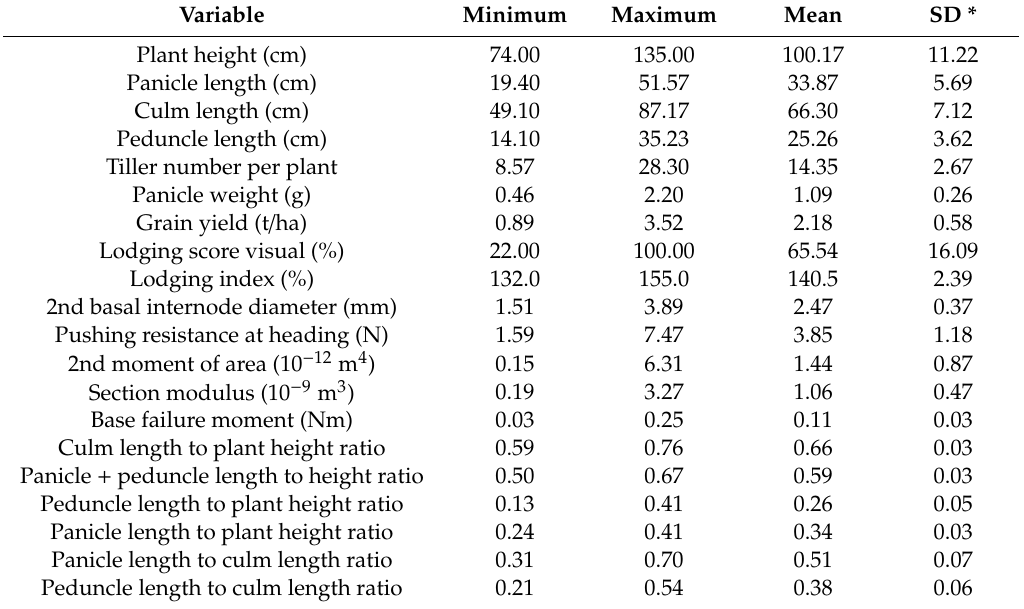
Figure 2. Internode and culm diameter trends across locations and years and along plants (internodes were counted from the ground upward). The same uppercase letters above bars indicates no significant differences ( p < 0.05) among environments for the average culm outer diameter, and the lowercase letters indicates the significant difference between internode outer diameter within a culm. Table 3. Descriptive statistics of agro-morphological traits and biomechanical properties of tested te ff accessions based on mean values of data from the three environments (location × year